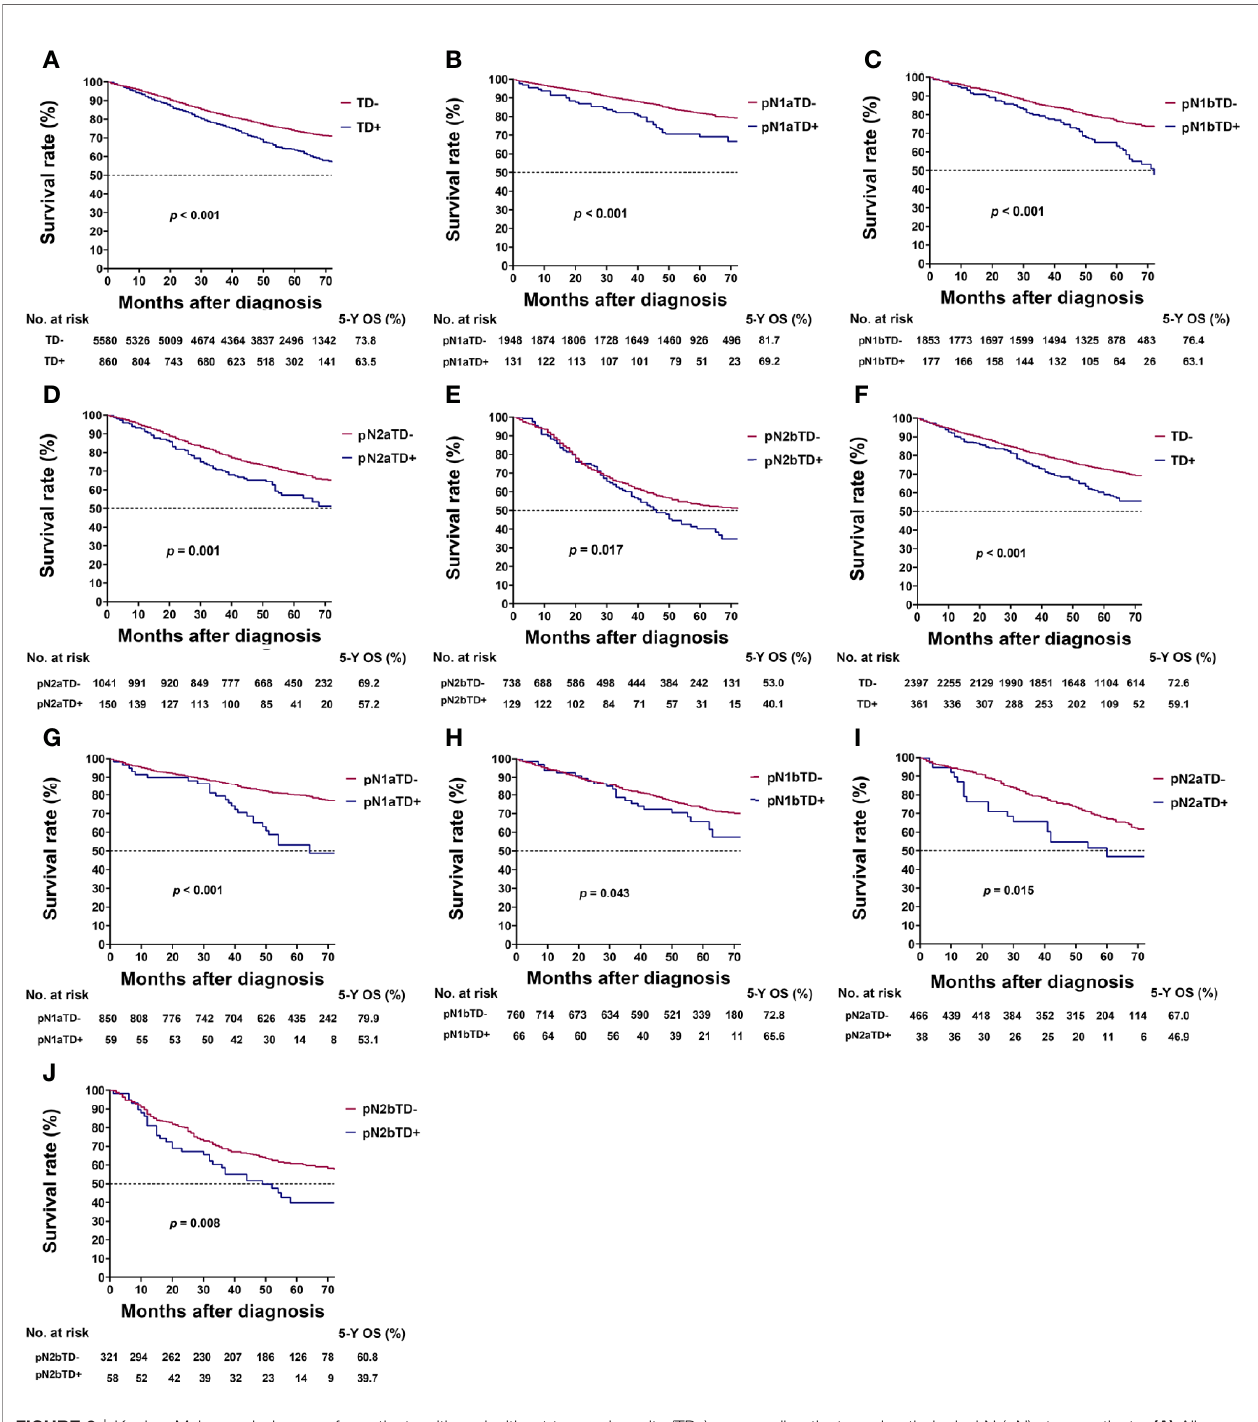
FIGURE 2 | Kaplan – Meier survival curves for patients with and without tumor deposits (TDs) among all patients and pathological N (pN) stage patients. (A) All patients in the training cohort; (B) pN1a substage in the training cohort; (C) pN1b substage in the training cohort; (D) pN2a substage in the training cohort; (E) pN2b substage in the training cohort; (F) all patients in the validation cohort; (G) pN1a substage in the validation cohort; (H) pN1b substage in the validation cohort; (I) pN2a substage in the validation cohort; (J) pN2b substage in the validation